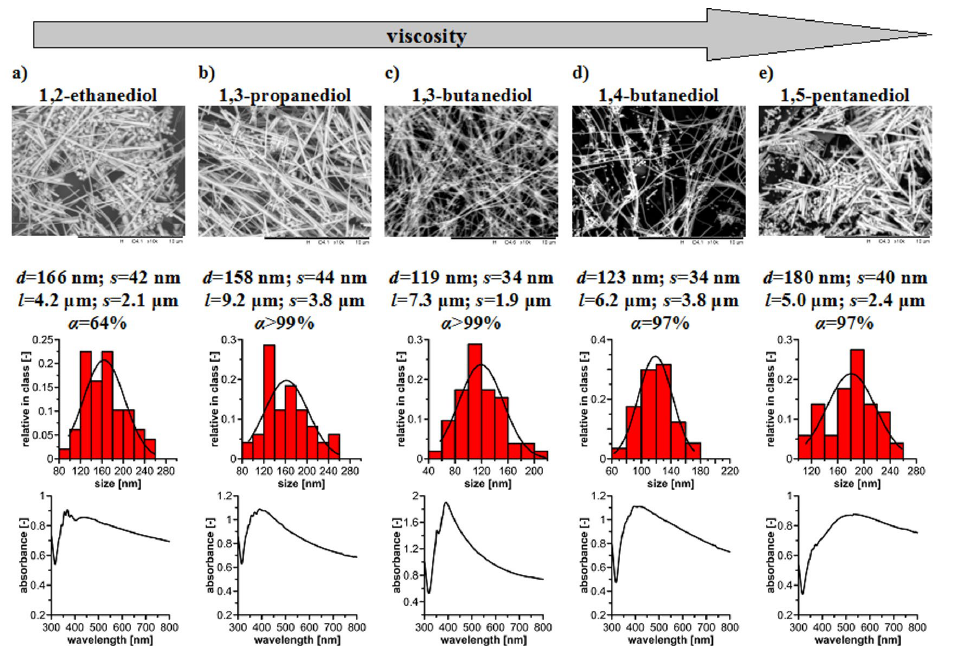
Figure 6. A summary of the properties of AgNWs produced with the application of the different reductants in a batch process under conventional heating conditions: ( a ) 1,2-ethanediol, ( b ) 1,3- propanediol, ( c ) 1,3-butanediol, ( d ) 1,4-butanediol, ( e ) 1,5-pentanediol. d , l —average diameter, length, respectively; s —standard deviation, α —conversion; scale bar 10 µ m.